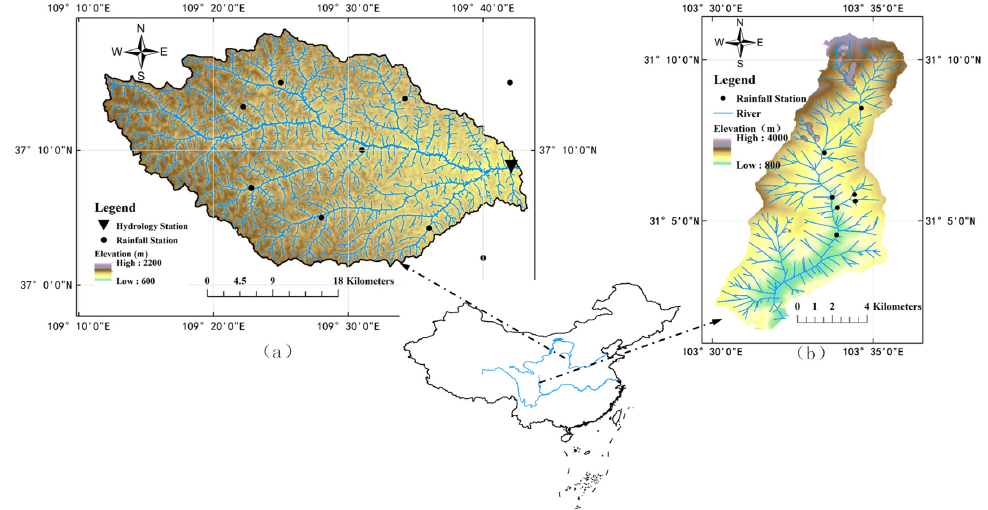
Figure 3. The distribution of hydrological and rainfall stations in ( a ) the upstream of the Qingjian River basin and ( b ) the Longxi River basin.